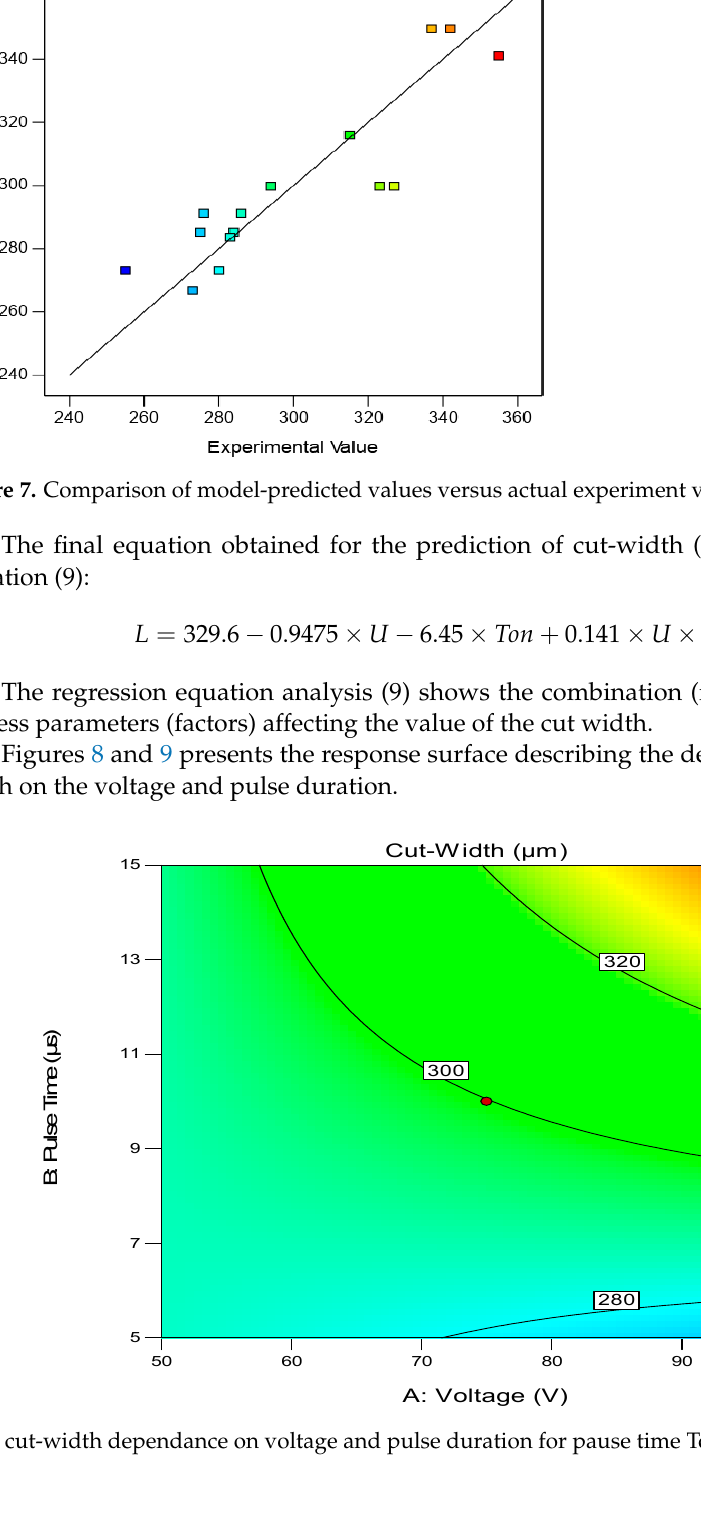
Figure 8. Contour plot for cut-width dependance on voltage and pulse duration for pause time Toff = 30 μ s.